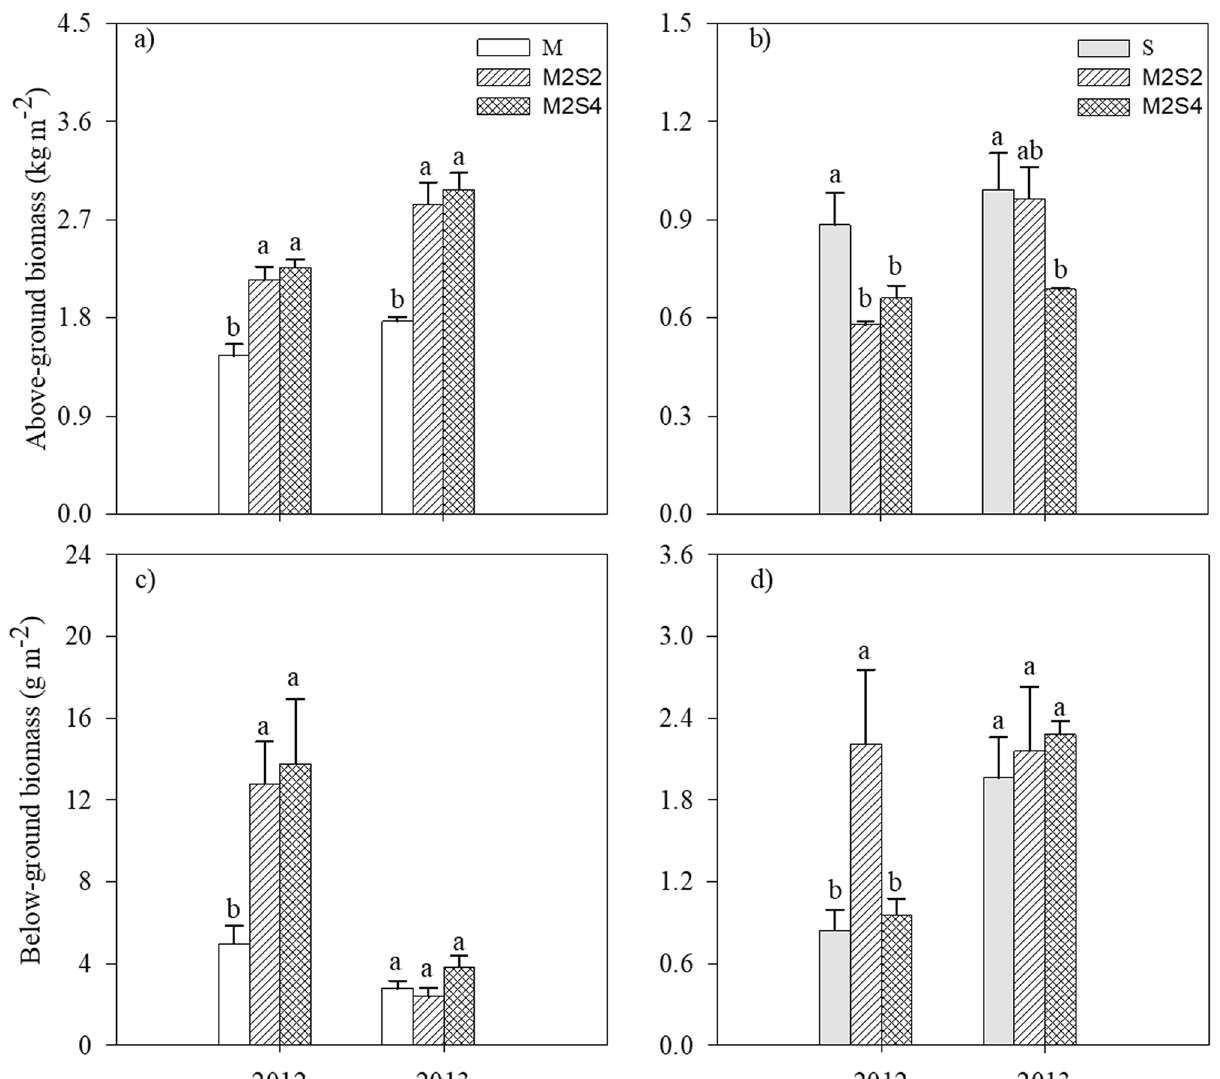
are significantly different between cropping systems for each year ( P < 0.05). M, sole-cropped maize; S, sole- cropped soybean; M2S2, two rows of maize intercropped with two rows of soybean; M2S4, two rows of maize intercropped with four rows of